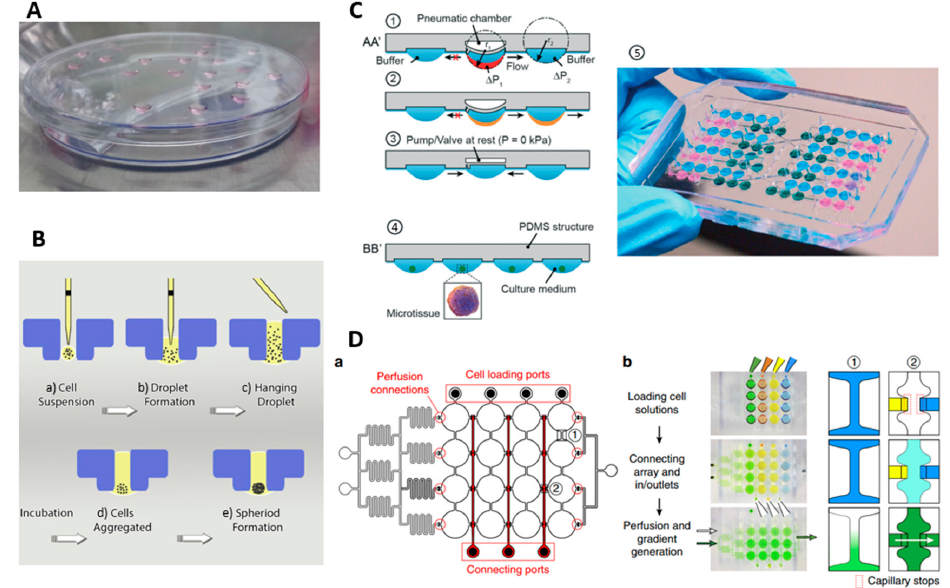
Figure 3. HD methods: ( A ) conventional HD method implemented in a Petri dish in which droplets are hanging from the lid; The Image was taken at Sharif Stem Cell Laboratory; ( B ) HD spheroid culture in a HD plate: ( a ) introduction of the cell suspension within the holes; ( b ) formation of the droplet by the capillary forces; ( c ) creation of an HD; ( d ) cell aggregation; ( e ) spheroid formation after one day. Redrawn with permission from [52] Copyright © 2010, Royal Society of Chemistry; ( C ) a HD-based µ SFC. The figure depicts the pneumatic chamber being pressurized ( 1 ) to promote the flow from the central HD to the right HD ( 2 ); The left valve which prevented backflow, is now open while the pneumatic chamber is unpressurized ( 3 ); Part ( 4 ) shows the spheroids in the HDs; ( 5 ) An image of the HD based µ SFC. Reproduced with permission from [54] Copyright © 2015, Royal Society of Chemistry; ( D ) a HD based µ SFC integrated with a concentration gradient generator (CGG) whose cell loading ports are distinct from its drug inlet ( a ); ( b ) The image depicts the cell loading channels (using four colours) and the concentration gradient generated on the chip (using green). Reproduced with permission from [30] Copyright © 2014, Springer